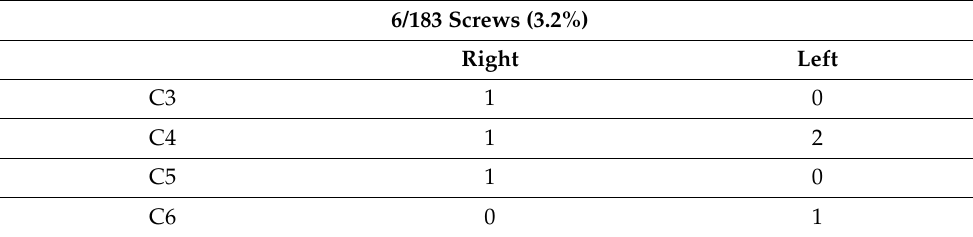
Table 1. Screw deviation rate.